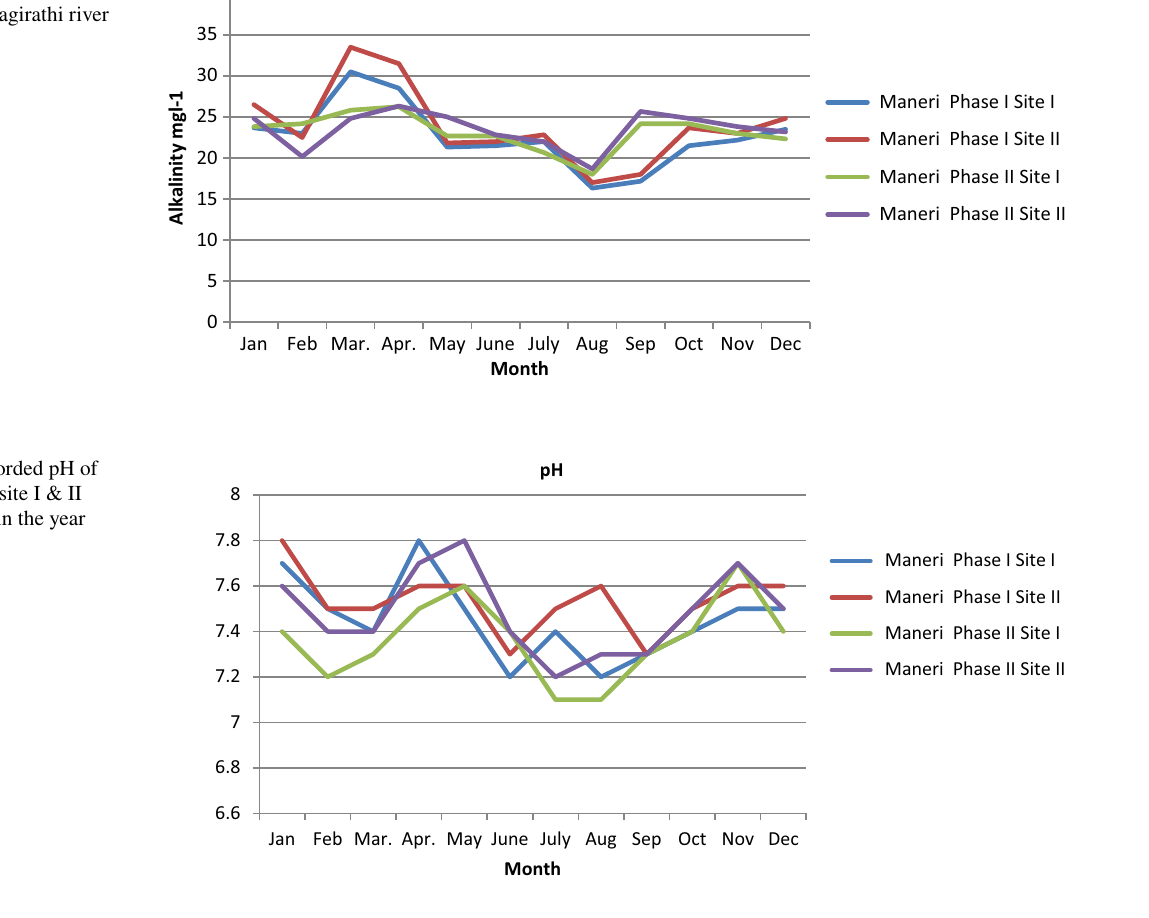
Fig. 6 Monthly recorded Alka- linity (mg l −1 ) of Maneri Phase I, II—site I & II Bhagirathi river in the year 2018